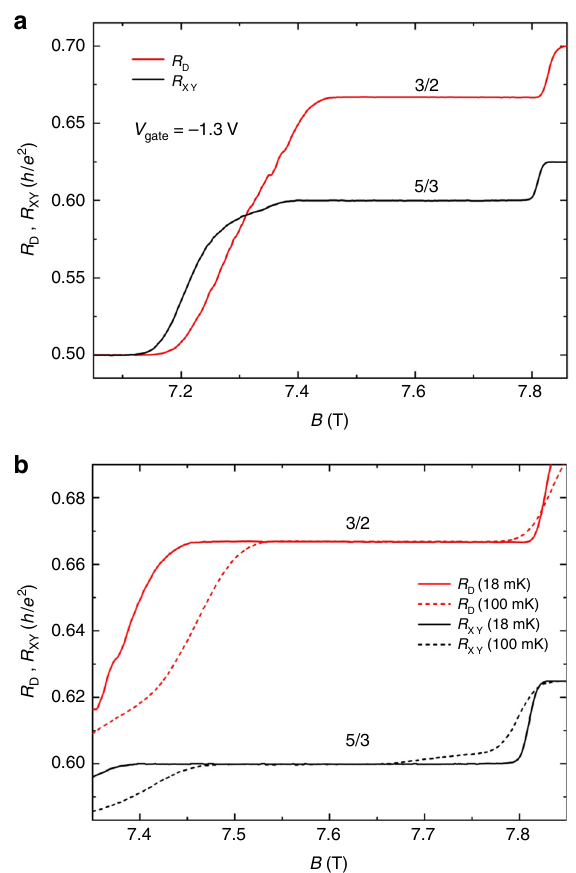
Fig. 2 The diagonal resistance and the Hall resistance traces around the ν = 5/3 FQH state with V = − 1.3 V. a At 18 mK, the Hall resistance (the (cid:1) (cid:3) (cid:1) (cid:3) gate = 5 black line) is quantized at h e , and the diagonal resistance (the red (cid:1) (cid:3) (cid:1) (cid:3) 2 3 = 3 line) is quantized at h e . b Temperature dependence of the 3/2 FQH 2 2 plateau of the diagonal resistance and the 5/3 FQH plateau of the Hall resistance in the bulk of the Hall bar. Source data are provided as a